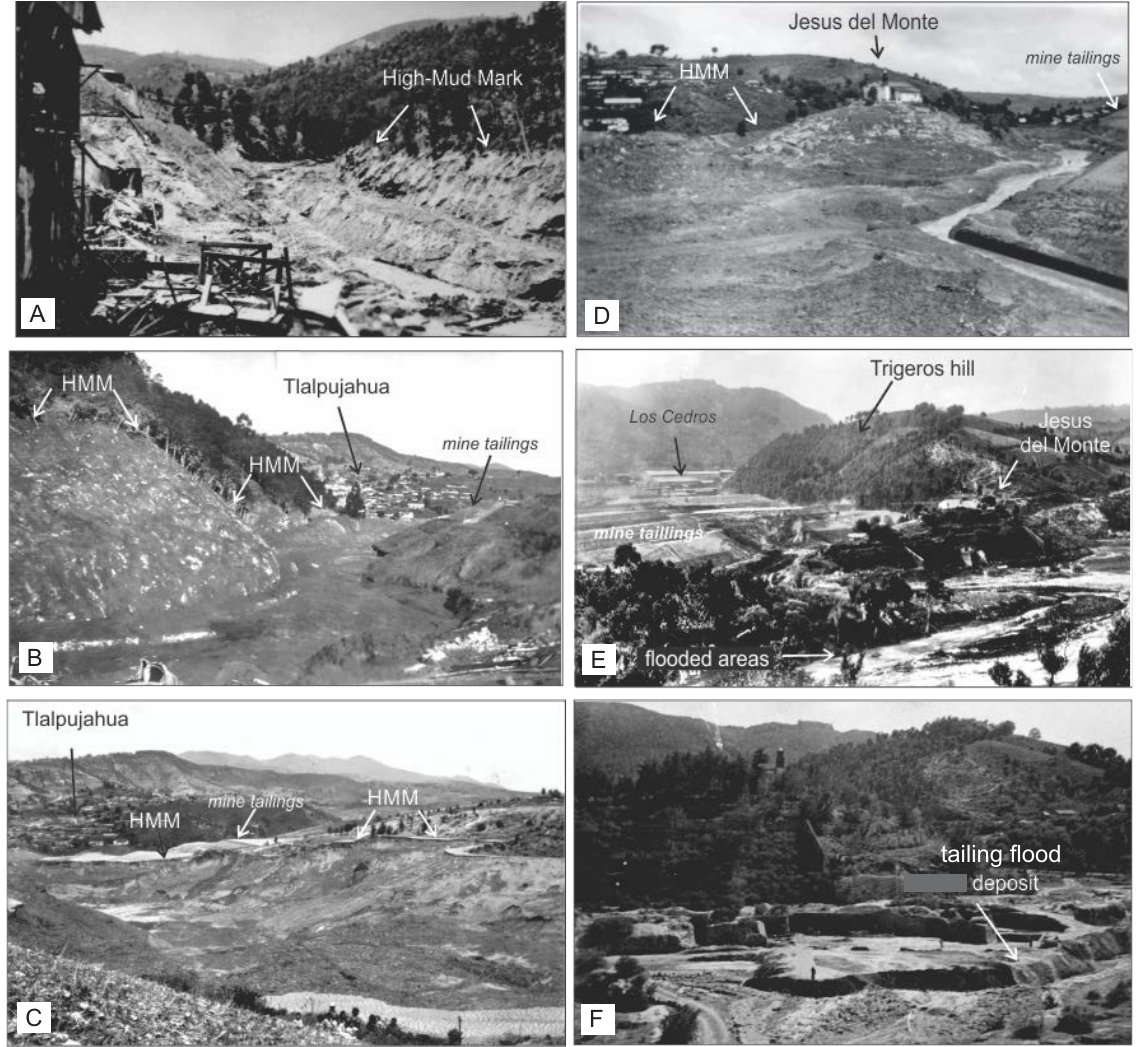
Figure 14. Photographs of damage caused by the tailings flood in 1937 at different locations of this study: Los Cedros metallurgical plant (a) , Trigueros hill (b) , the Dos Estrellas stream between Trigueros and Jesus del Monte (c) , and Jesus del Monte (d) – (f) . HMM: high-mud